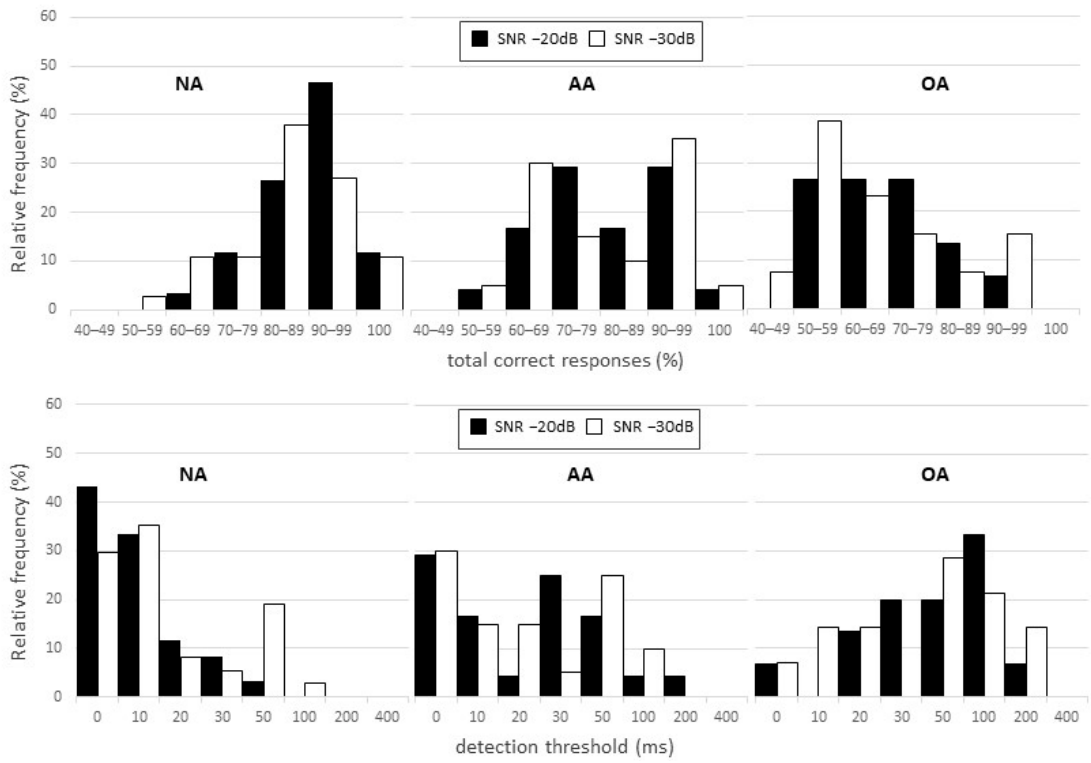
Figure 3. Distribution of the ears according to the percentage of correct responses (BMTP) and detection thresholds (BMTT) obtained in the backward masking test (BMT) for each signal-to-noise ratio (SNR). NA: normal adults group; AA: abnormal adults group; OA: older adults group. Significant differences were observed between the groups regarding the mean values of the BMT measures (BMTP at SNR -20 dB: χ 2 (2) = 35.485; BMTT at SNR − 20 dB: χ 2 (2) = 34.466; BMTP at SNR − 30 dB: χ 2 (2) = 33.956; BMTT at SNR − 30 dB: χ 2 (2) = 33.573, all p values < 0.001). In general, the average performance of the AA and OA groups was worse than that of the NA group. Additionally, the OA group performed worse than the AA group in the BMT test, except for BMTT at SNR − 20 dB (Table 2). Table 2. Descriptive statistics and comparison of performance in percentage of correct responses (BMTP) and target sound detection threshold (BMTT) for the three groups for the backward mask- ing test (BMT), according to the signal-to-noise ratio (SNR). SNR (dB)